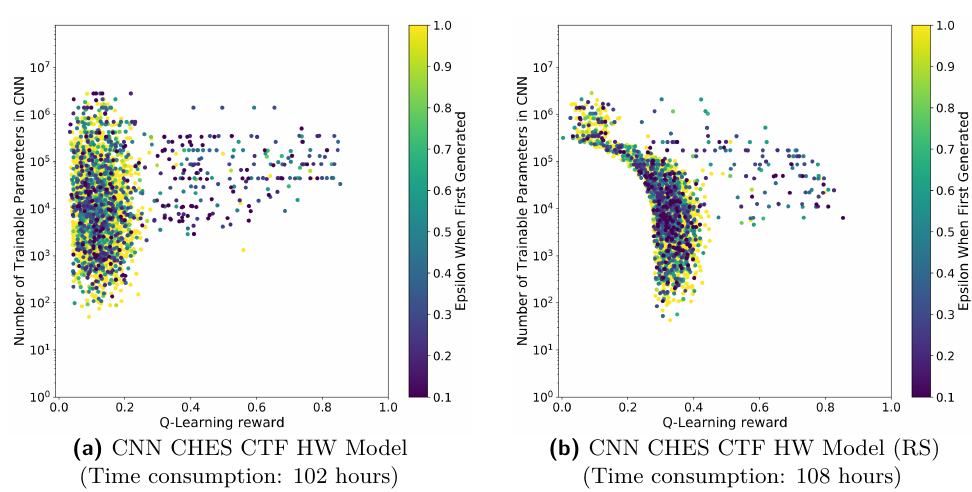
Figure 10: An overview of the number of trainable parameters, reward, the total search time, and the ε a neural network was first generated for the CHES CTF dataset experiments.